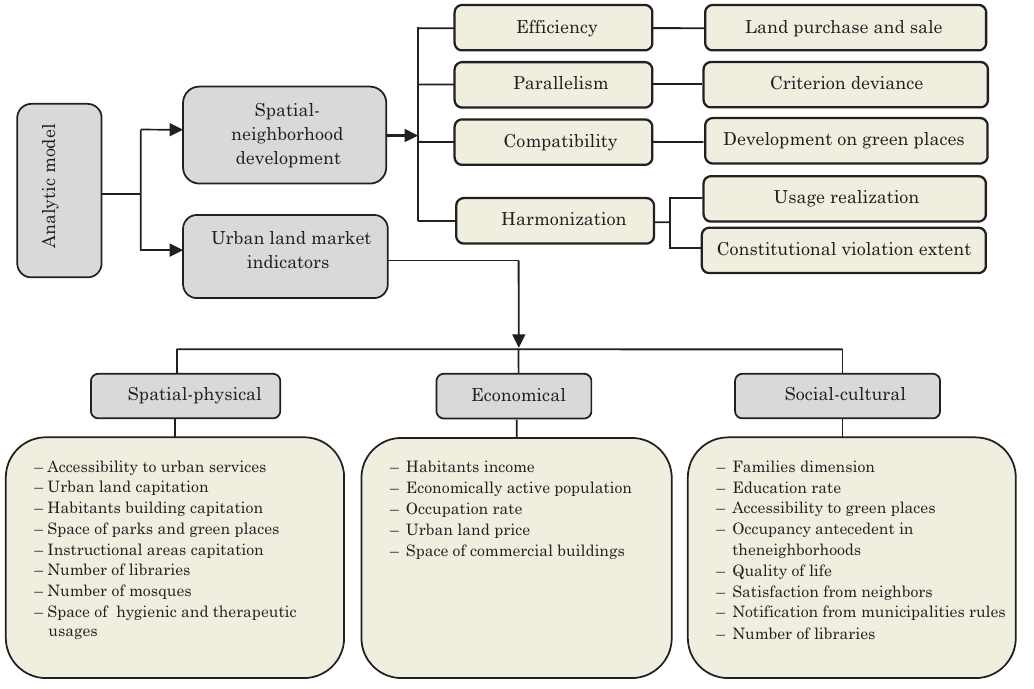
Fig. 2. The analytic model of urban land market role in spatial development of the city Table 2. Status of land price and indicator of urban land market in the third district of Mashhad Usage realiza- Constitutional Change in us- Neighborhoods Land price Extent of pur- Habitant in- tion (percent) ages of green (IRR)* chase and sale come deviance places (meter) (IRR)*